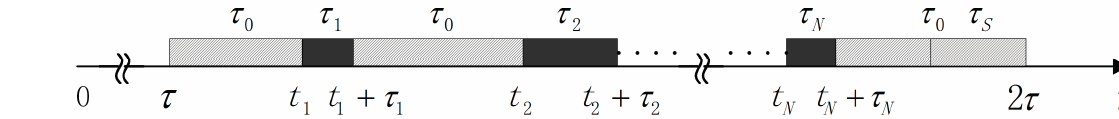
τ on time axis in the first normal replenishing m